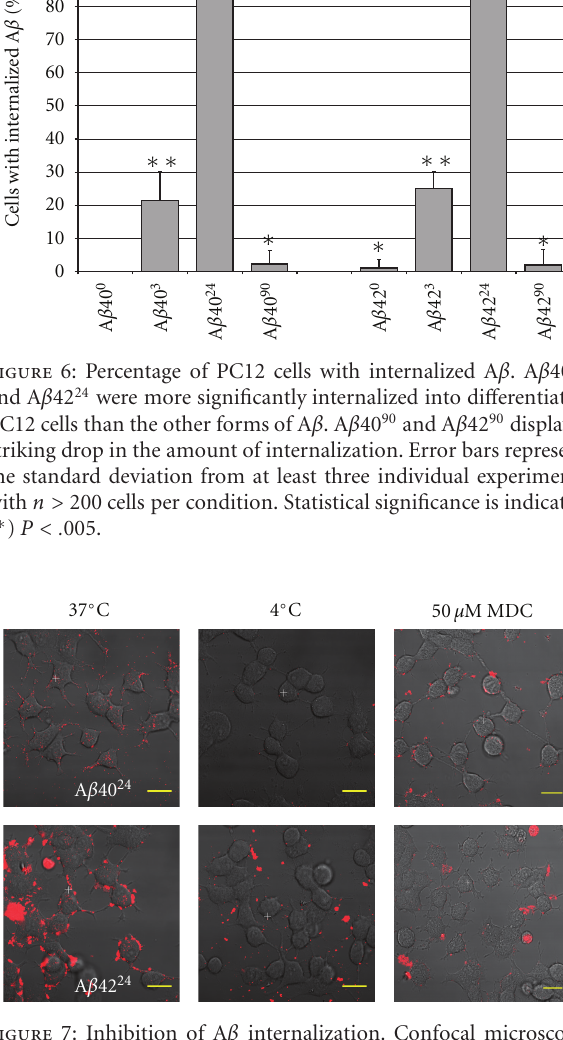
Figure 7: Inhibition of A β internalization. Confocal microscopy images of di ff erentiated PC12 cells treated with A β 40/42 24 for 4 hours. All scale bars are 20 μ m in length. Internalization was only observed at 37 ◦ C. Membrane integrity was maintained throughout all treatments, indicating that internalization is mediated through a cellular process such as clathrin-dependent